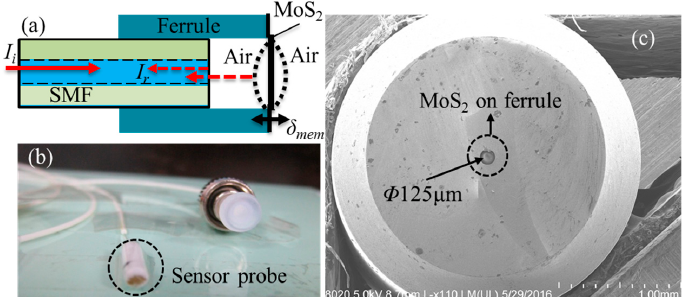
Figure 1. ( a ) Schematic diagram and ( b ) physical picture of the Fabry ‐ Perot (F ‐ P) sensor probe. ( c ) Microscopic image of the molybdenum disulfide (MoS 2 ) diaphragm adhered to ferrule.